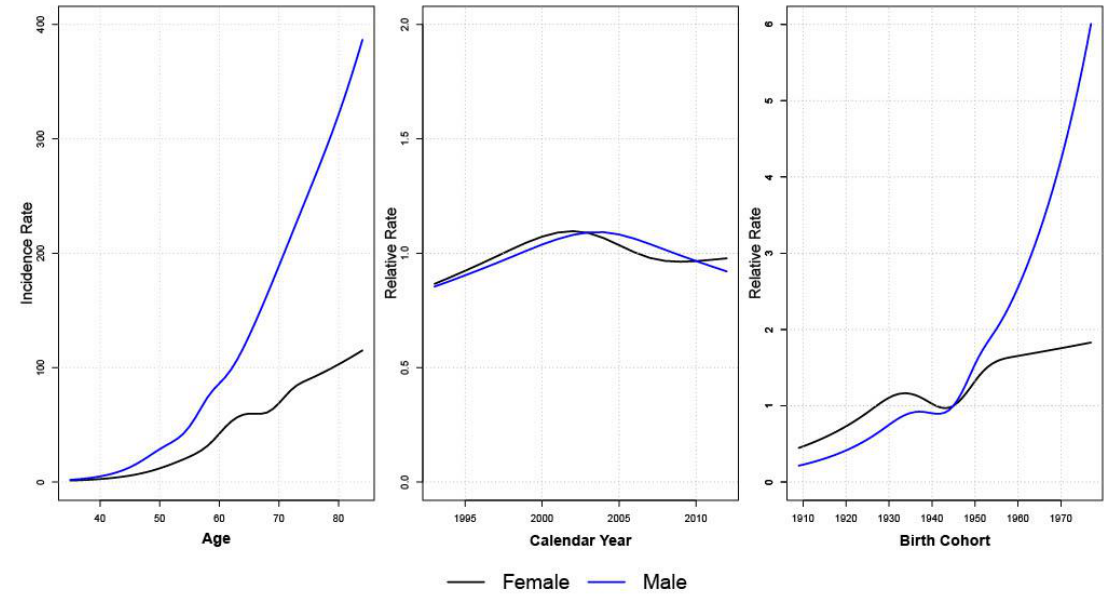
Figure 3. Age, period, and cohort effects of AC-P models for male and female CCA.